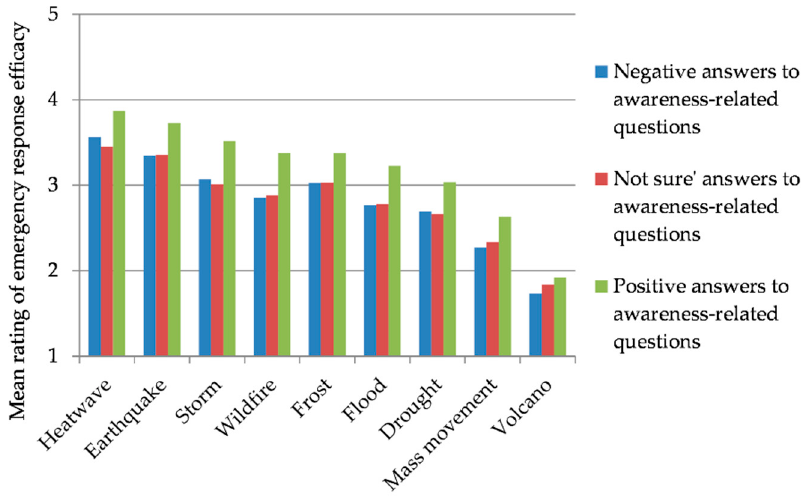
Figure 6. Comparison of mean rating (on a 1–5 scale) of perceived emergency-response efficacy and likelihood of occurrence, across all hazard types.